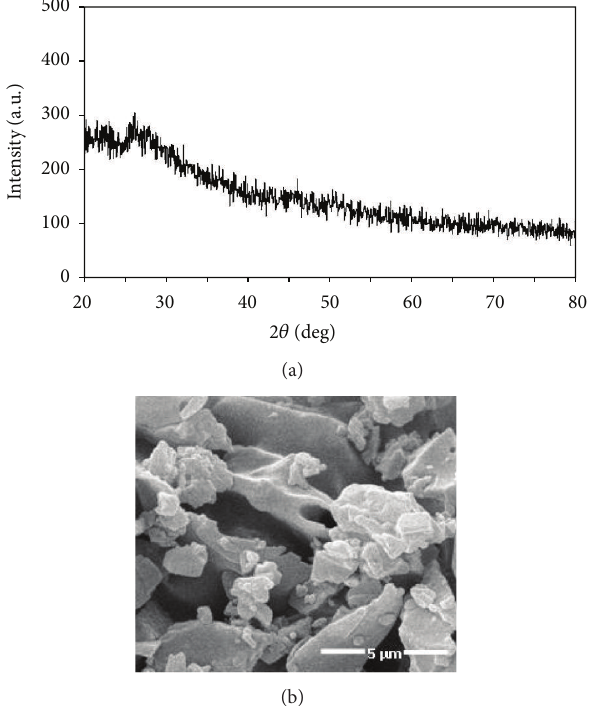
Figure 2: (a) XRD patterns and (b) SEM image of as-synthesized vanadium oxide sample prepared by the microwave heating at 300